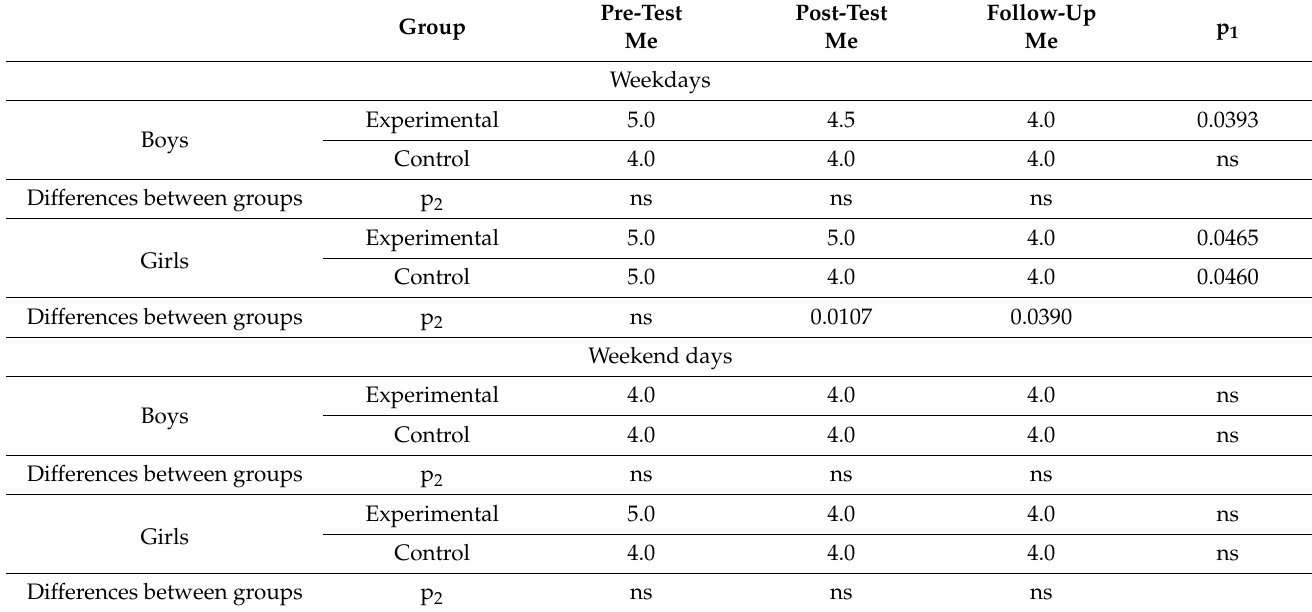
Table 3. Comparison of the values (median) of the screentime with Friedman’s ANOVA and within the genders (with Mann–Whitney U ) in the examined 7-year-old